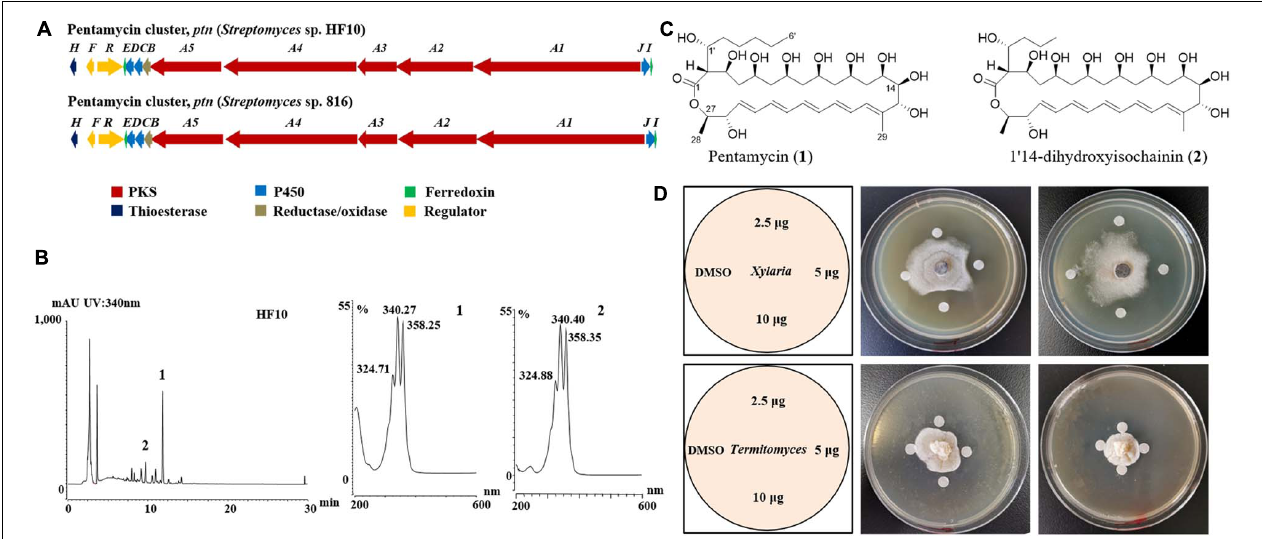
FIGURE 3 | Streptomyces sp. strain HF10 produces antibiotics pentamycin and 1 (cid:48) 14-dihydroxyisochainin. (A) The genetic organization of the pentamycin BGC of strain HF10 compared with the reported one in Streptomyces sp. 816. The BGC of pentamycin in strain HF10 was identified by whole genome sequencing and bioinformatic analysis. (B) HPLC profiles of metabolites from strain HF10 (left) and UV/vis spectra of compounds 1 and 2 (right). (C) The chemical structures of pentamycin (1) and 1 (cid:48) 14-dihydroxyisochainin. (2). (D) Antifungal activity of pentamycin and 1 (cid:48) 14-dihydroxyisochainin by disc diffusion assay. Pentamycin and 1 (cid:48) 14-dihydroxyisochainin were purified from strain HF10 as described in section “Materials and Methods.” Pentamycin (middle) and 1 (cid:48) 14-dihydroxyisochainin (right) against Xylaria sp. Pentamycin (middle) and 1 (cid:48) 14-dihydroxyisochainin (right) against Termitomyces sp. Left, schematic map showing sample arrangement in experiments. A gradient amount (2.5, 5.0, and 10 µ g) of pentamycin or 1 (cid:48) 14-dihydroxyisochainin was used. An agar piece covered with fungal mycelium ( Xylaria sp. or Termitomyces sp.) was inoculated at the center of the PDA plate for 7 days at 30 ◦ C. Sterile discs containing the compounds dissolved in DMSO were placed around the colony. The plates were cultured at 30 ◦ C for 3 days and observed on daily basis.